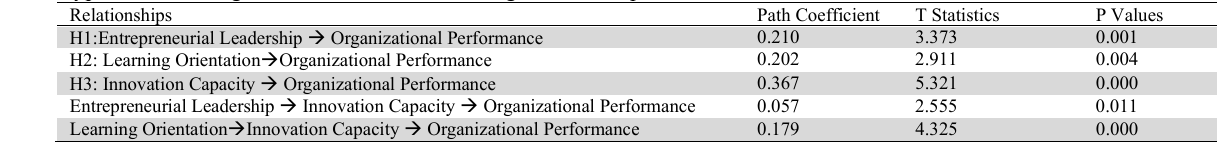
Hypotheses Testing for the Direct and Mediating Relationships